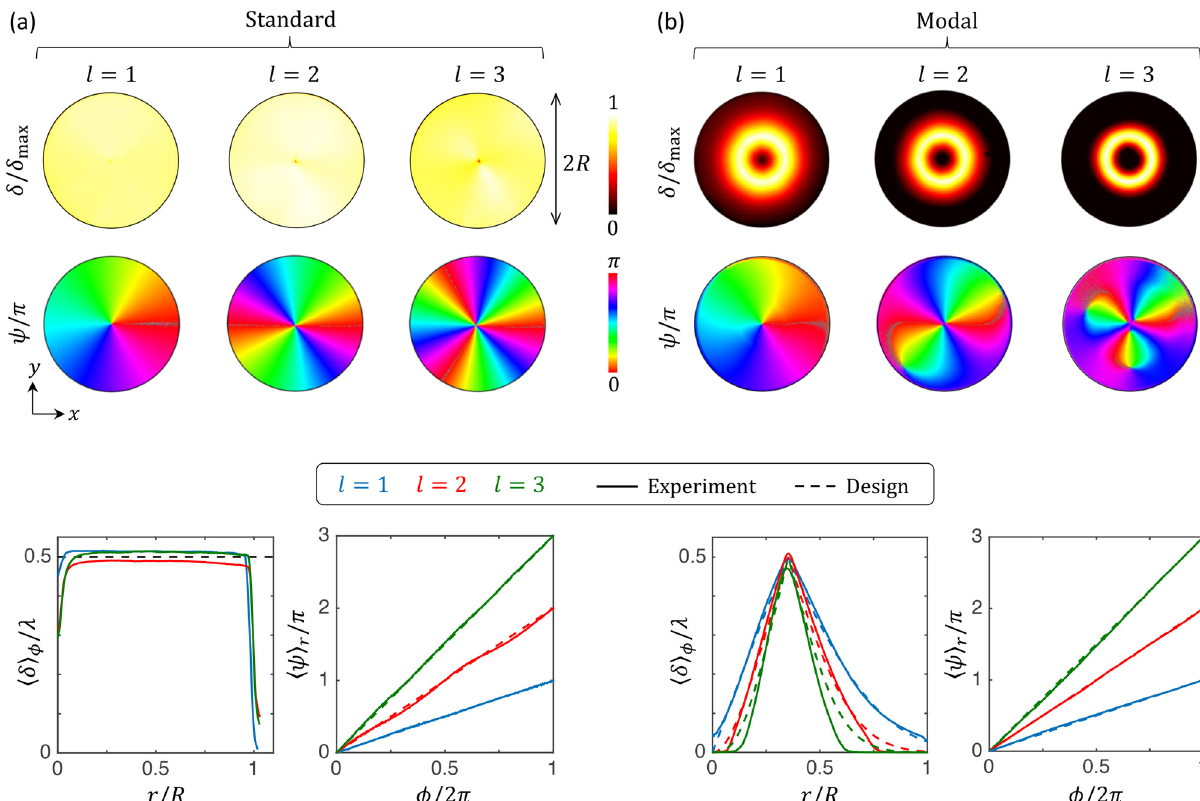
Figure 2: Structural polarimetric characterization of the samples. (a) and (b) Experimental spatial distributions of the retardance 𝛿 and azimuth 𝜓 retrieved by polarimetric imaging of the nanostructured area of diameter 2 R for standard and modal ( p = 0) vortex beam shapers, respectively, for l = 1 (red), l = 2 (green) and l = 3 (blue). Upper part: = max[ 𝛿 ( x , y )] , for l = (1 , 2 , 3). Bottom part: radial profiles of the reduced normalized maps 𝛿 ∕ 𝛿 and 𝜓 ∕ 𝜋 in the ( x , y ) planes, where 𝛿 max max ∕ 𝜋 , where ⟨ … ⟩ retardance ⟨ 𝛿 ⟩ 𝜙 ∕ 𝜆 and azimuthal profiles of the reduced azimuth ⟨ 𝜓 ⟩ 𝜙, r respectively refers to azimuth-average over the r range 0 < 𝜙 < 2 𝜋 and radial-average over the range 0 < r < R (standard case) and 0 . 2 R < r < 0 . 45 R (modal case). Solid lines: experimental ,𝜓 } (a) and { 𝛿 ,𝜓 } data. Dashed lines: analytical designs given by { 𝛿 standard standard l , 0 l , 0